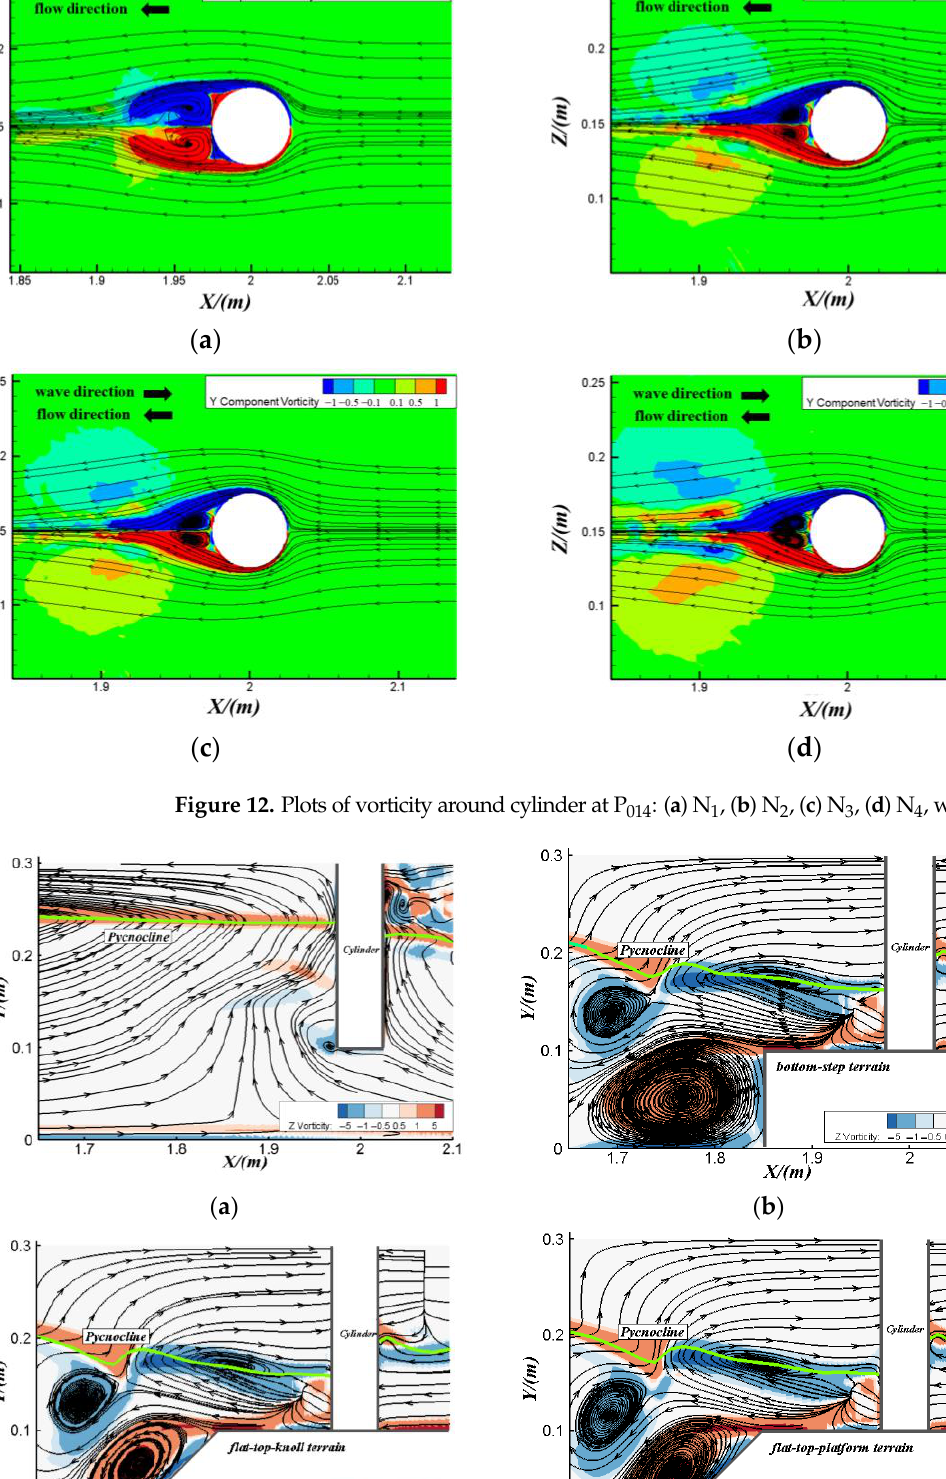
In summary, the existence of bottom terrains weakens the forces on the upper parts